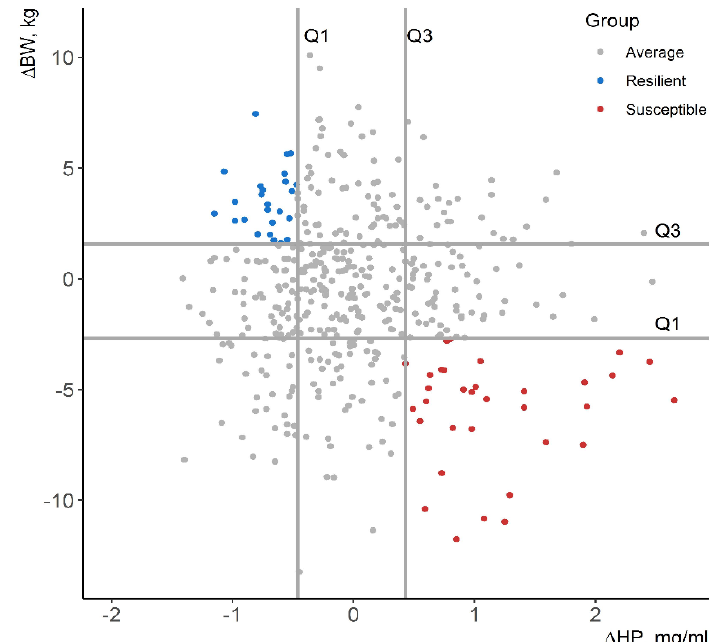
Figure 2. Classification of pigs as resilient, average, and susceptible based on the first (Q 1 ) and the third (Q 3 ) quartiles of ∆ BW and ∆ HP. ∆ BW: body weight deviation from the expected growth curve of control pigs at 28 days post-vaccination, ∆ HP: haptoglobin increment at 4 days post-vaccination.